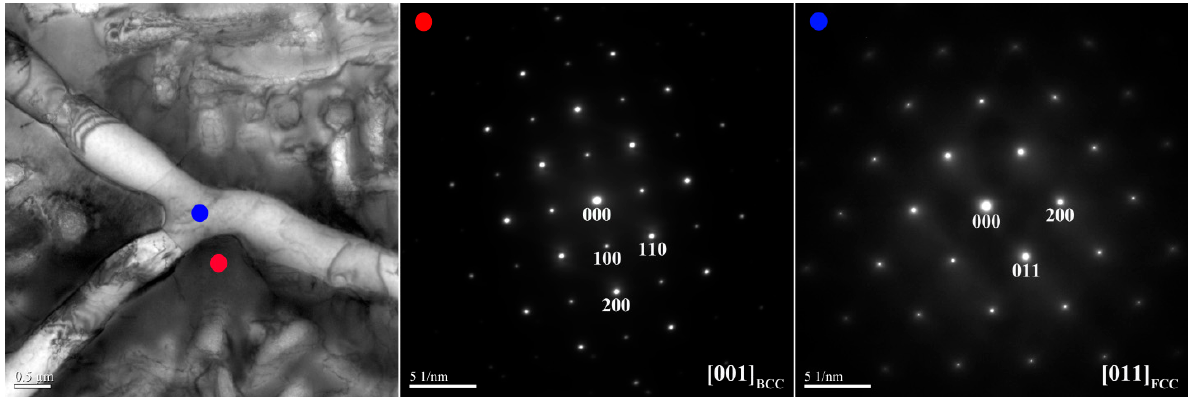
Figure 4. TEM bright-field images and SAED patterns of the interdendrite for the X 0 as-cast alloy (red dot: ordered BCC; blue dot: FCC).